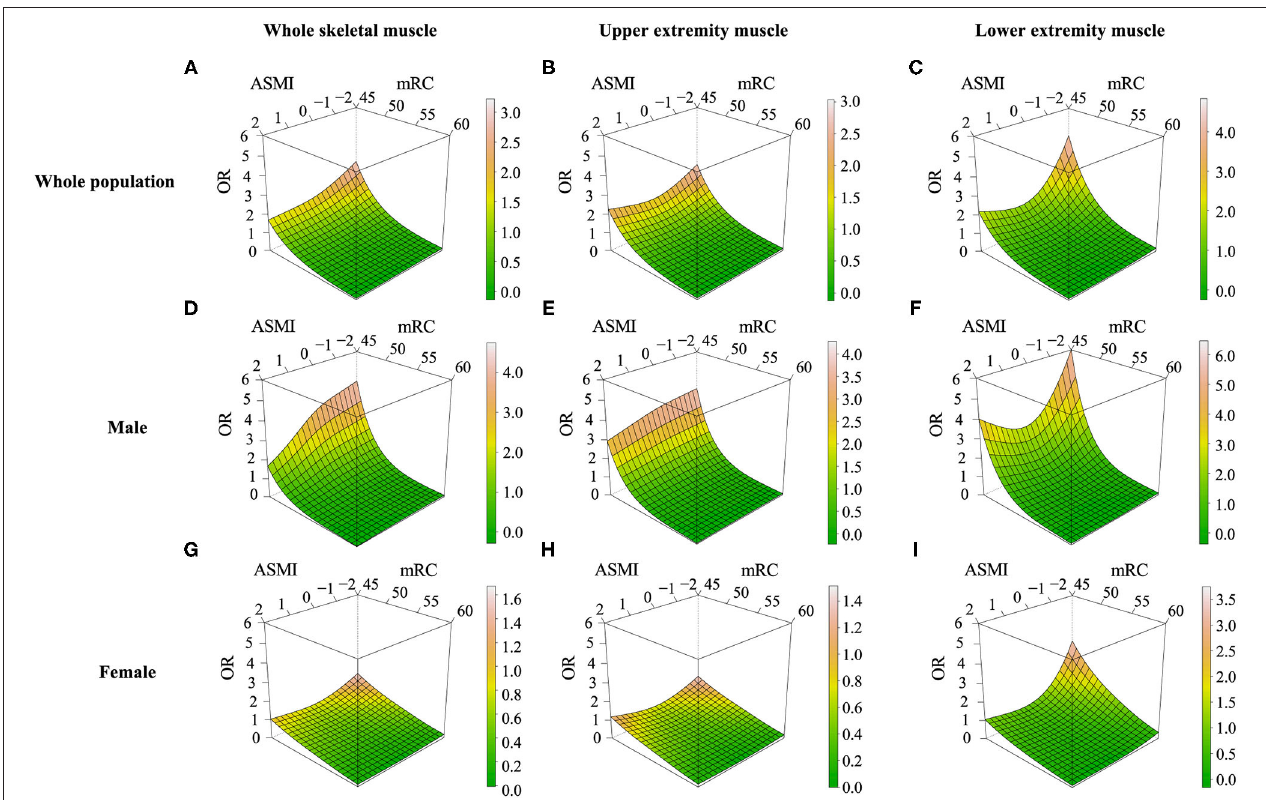
FIGURE 3 | Restricted cubic spline models for low muscle mass, low muscle strength, and unfavorable outcomes at 90 days. Effect of low muscle mass and low muscle strength on functional outcomes in ischemic stroke or TIA patients assessed with (A,D,G) Z -transformed appendicular skeletal muscle mass index, (B,E,H) only upper extremity muscle mass (C,F,I) only lower extremity muscle mass. OR, odds ratio; ASMI, Z -transformed appendicular skeletal muscle index; MRC, Medical Research